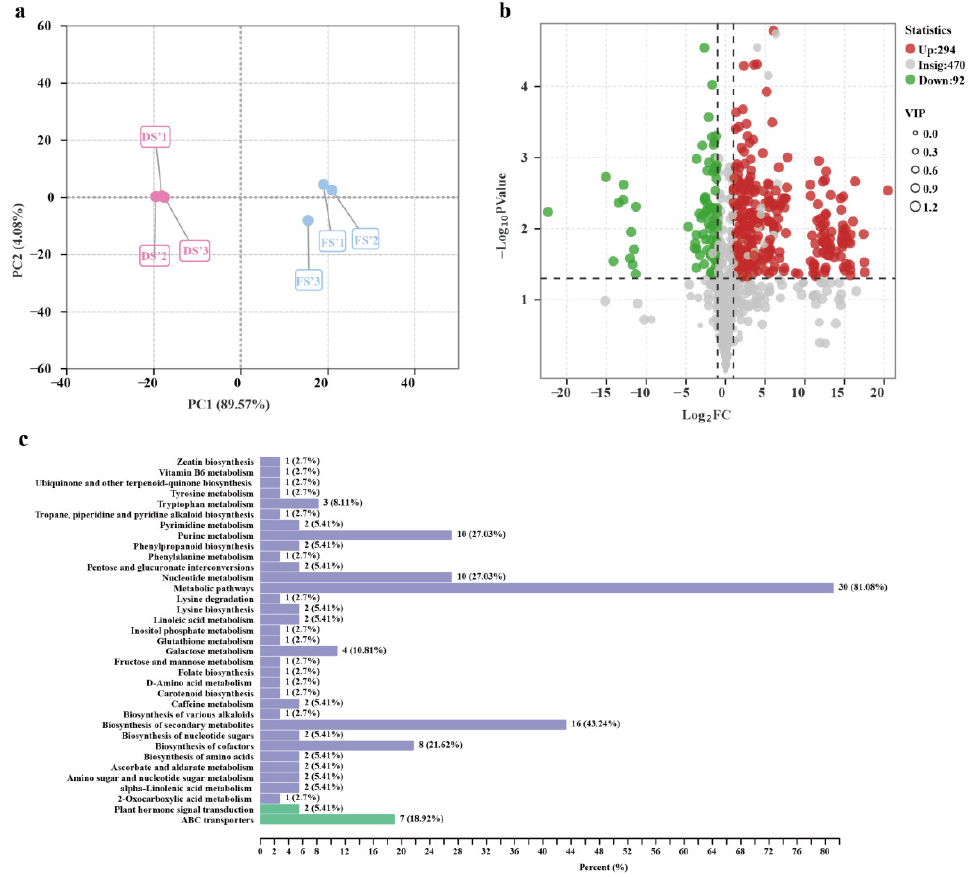
Figure 9. Principal component analysis (PCA) clustering based on metabolome data ( a ). Differential metabolite volcanic map ( b ). KEGG classification map of downregulated metabolites ( c ). DS’, exotesta-removed dry or dormant seeds; GS’, exotesta-removed germinated seeds. Table 1. Potential endogenous inhibitors of Chinese pistache seeds by fold change.